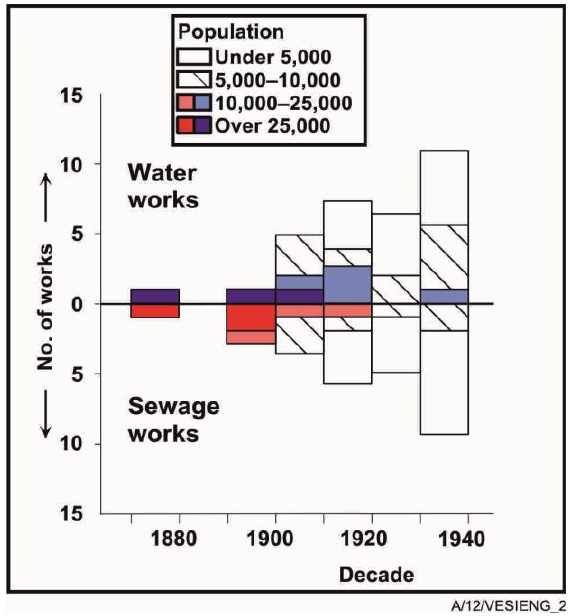
Figure 2. Establishment of urban water supply and sewerage systems versus population size in Finland ([45], p. 22, modified).